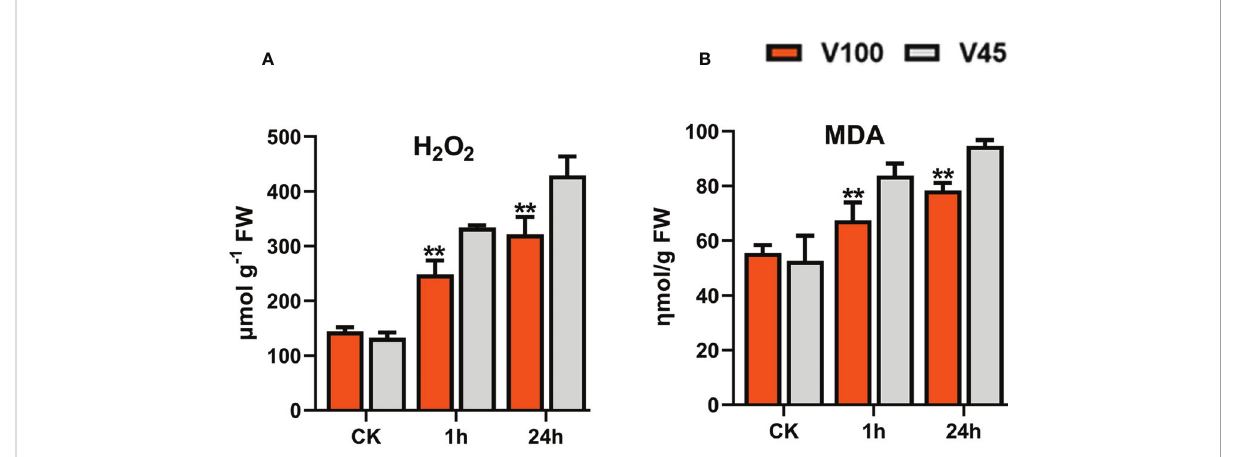
FIGURE 9 Comparison of H 2 O 2 and MDA accumulation in V100 and V45. (A) H 2 O 2 levels under control (CK) and cold stress in V100 and V45. (B) . MDA levels under control (CK) and cold stress in V100 and V45. Data was analyzed with the Statistix 8.1. The ** asterisks indicate the signi fi cant differences at p-value <0.01.